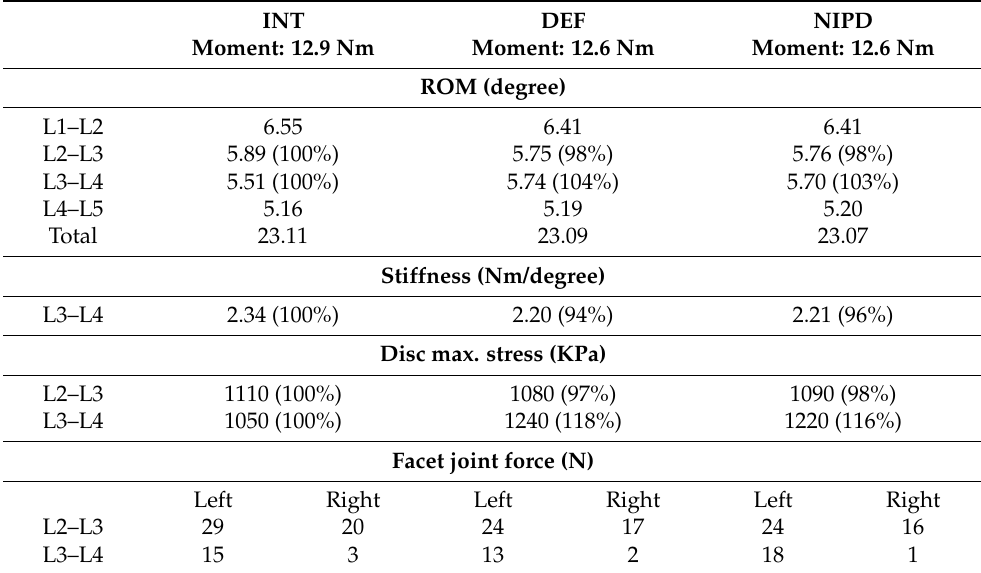
Figure 7. Disc stress distribution in the three FE models in extension: ( A ) implanted level L3–L4 and ( B ) adjacent level L2–L3. Note: the arrow indicates the region of high stress. Table 4. Comparison of the biomechanical characteristics among the three FE models in lateral bending. INT Moment: 12.9